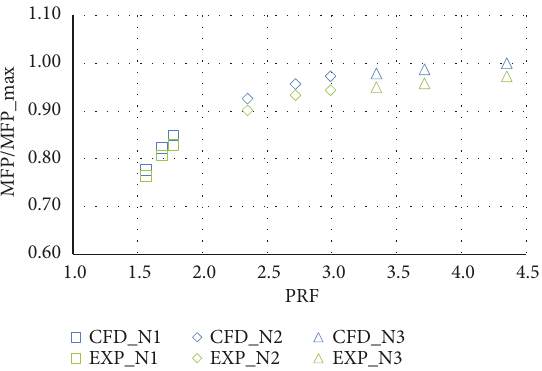
Figure 8: 𝜂 ts vs PRF in partial shroud admission, CFD (blue) and experimental data (green).